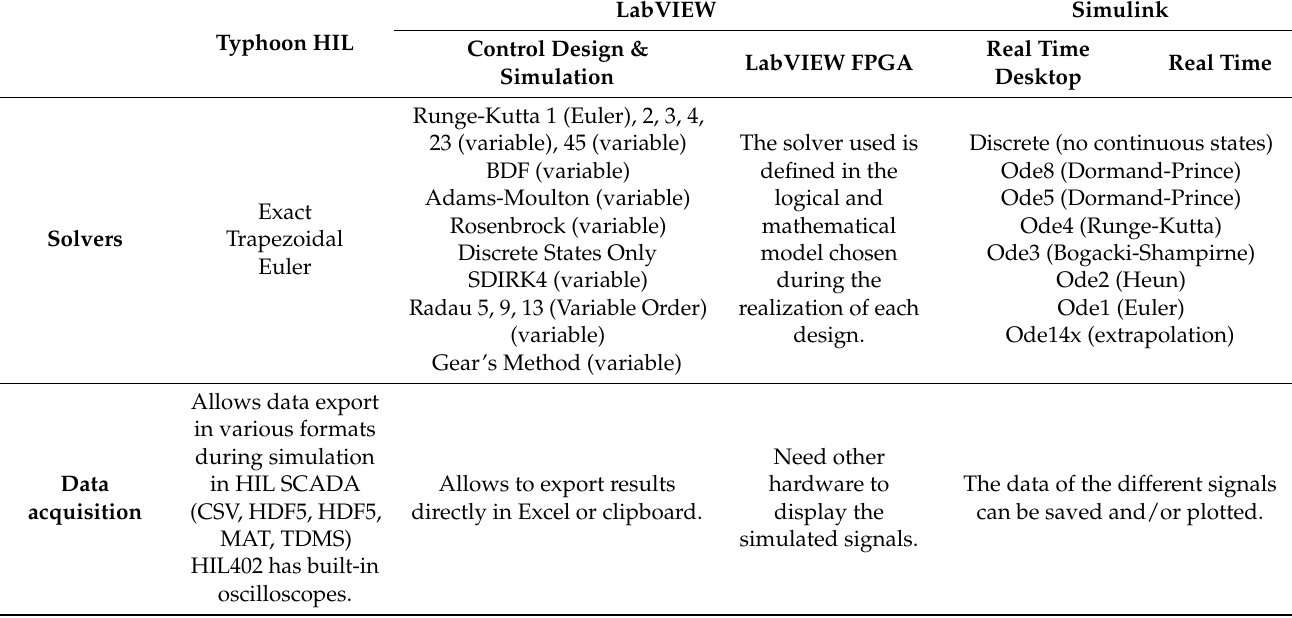
Table 1. Comparative analysis of Typhoon, LabVIEW (“Control Design & Simulation” and “LabVIEW FPGA”) and MATLAB/Simulink (“Real Time Desktop” and “Real Time”) tools, according to [49]. (Reprinted with permission from ref.